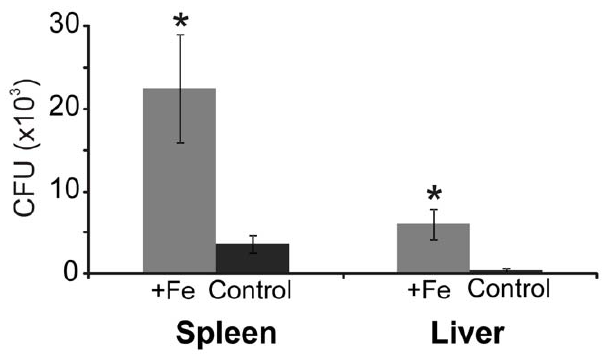
Figure 1. Iron supplementation increases mice susceptibility to P. brasiliensis infection. Colony forming units recovered from the spleen and liver of mice infected with P. brasiliensis . Mice were supplemented with iron (grey bars) or 0.9% (w/v) NaCl (black) for 15 days prior and during infection. Error bars represent standard deviation from four biological replicates while * represents p #